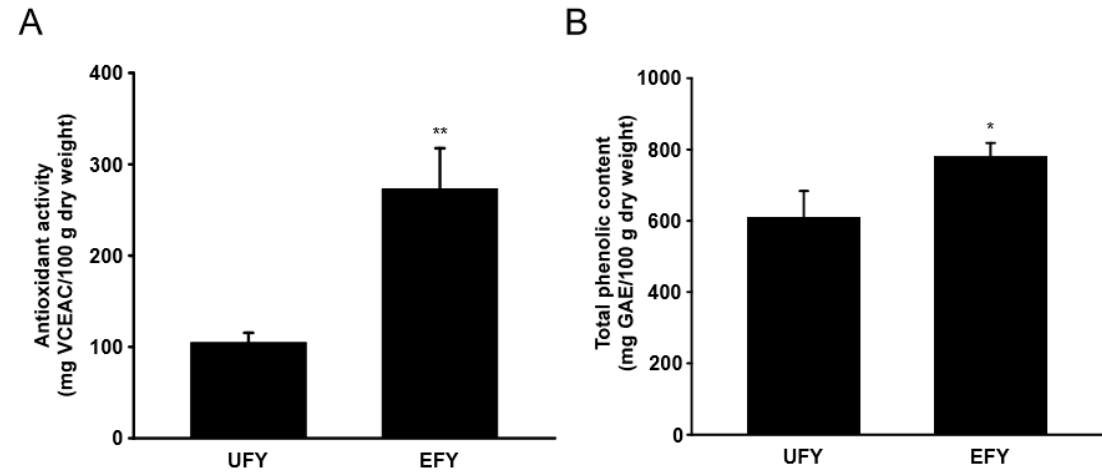
Figure 6. EFY has higher antioxidant activity and total phenolic content than UFY. ( A ) Antioxidant activity of EFY vs. UFY. The values were estimated as mg VCEAC per 100 g dry weight. ( B ) Total phenolic content of EFY vs. UFY. The values are mg gallic acid equivalent (GAE) per 100 g dry weight. Data ( n = 3) are mean values ± SD. * significant difference ( p < 0.05) and ** ( p < 0.01) between UFY and EFY groups.